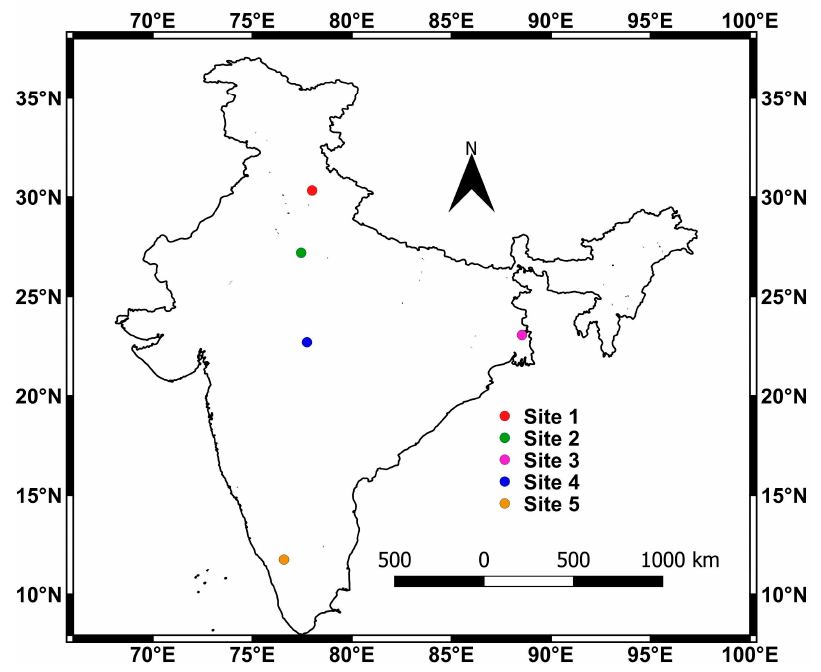
Figure 1. Location of the five BREB tower sites.